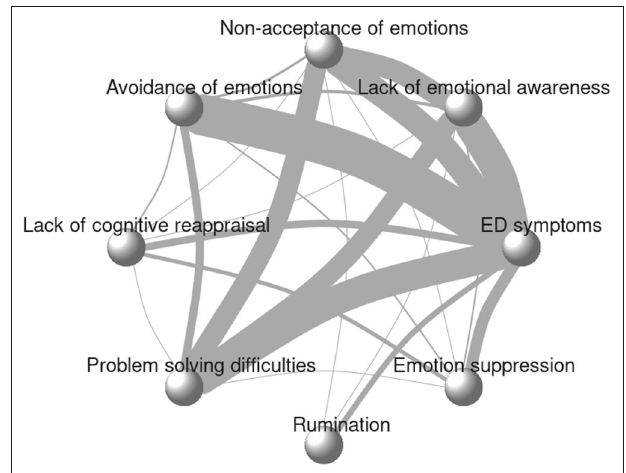
FIGURE 2 | Initial network plot. Line thickness represents the number of studies reporting the